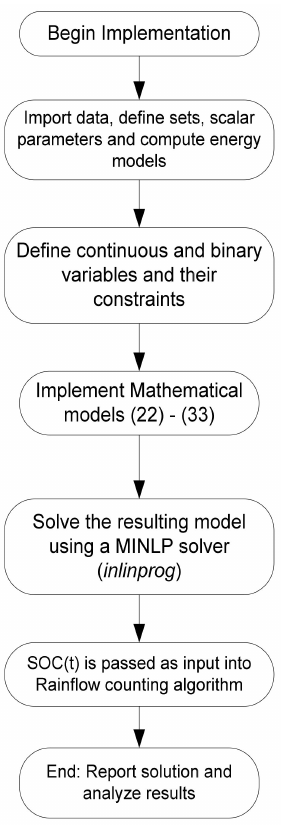
Figure 7. Flow chart of the proposed MINLP optimization technique for the energy management of the